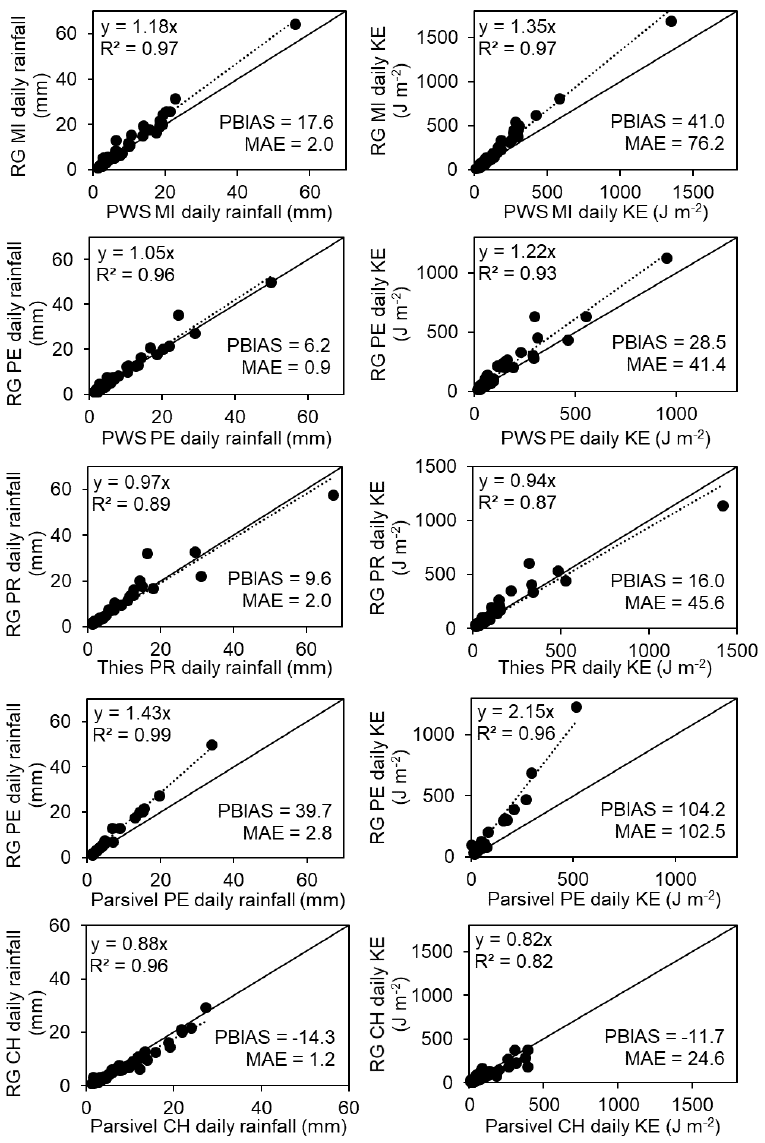
Figure 5. Rain gauge (RG) and disdrometer comparison of daily rainfall and rainfall kinetic energy for the sites Mistelbach (MI), Petzenkirchen (PE), Prague (PR) and Christchurch (CH).